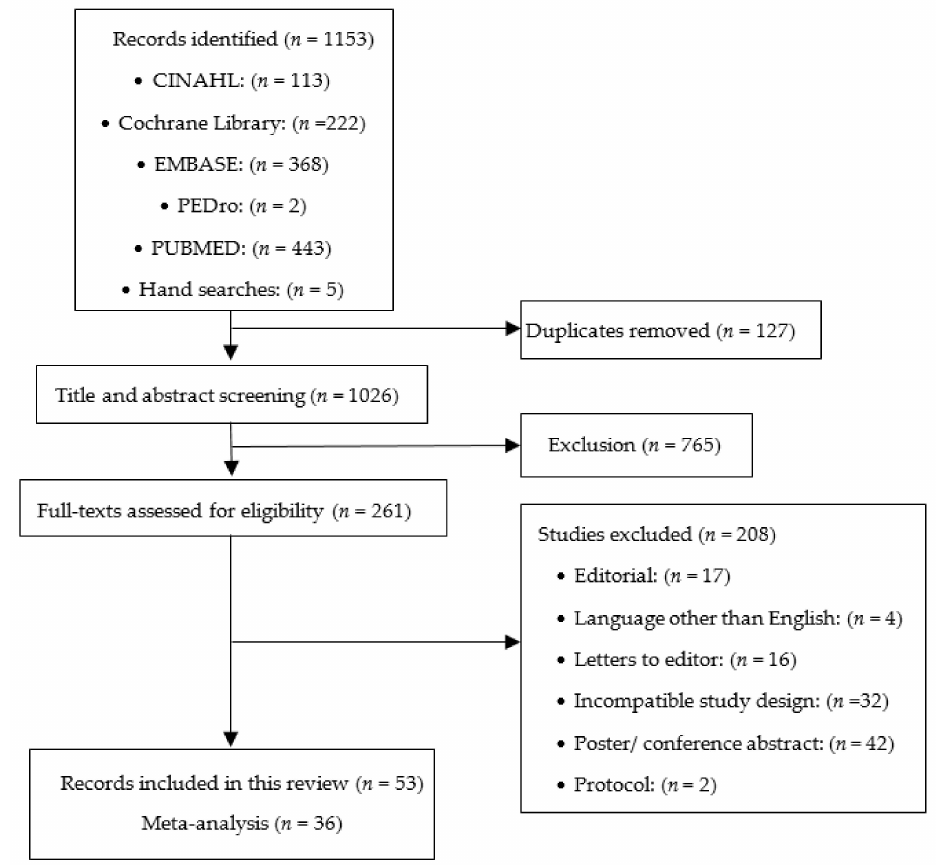
Figure 1. Flow of studies through the